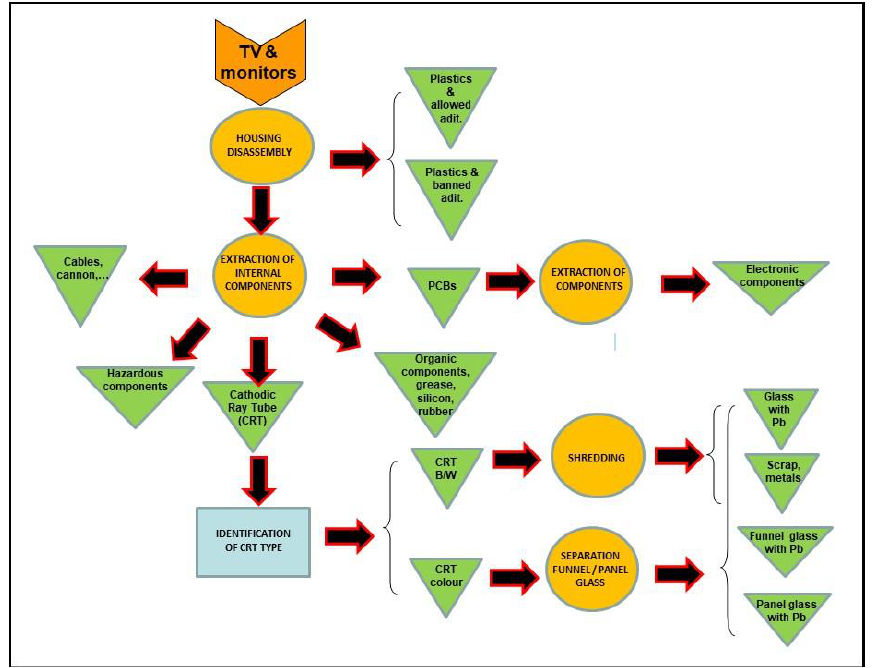
Figure 5. Flow diagram of the disassembly process.